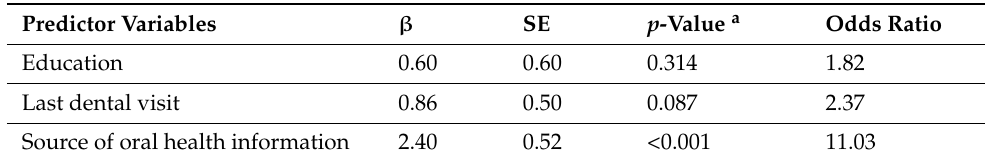
Table 9. Multivariate analysis between toothbrushing frequency at least twice a day combined with interdental cleaning and independent